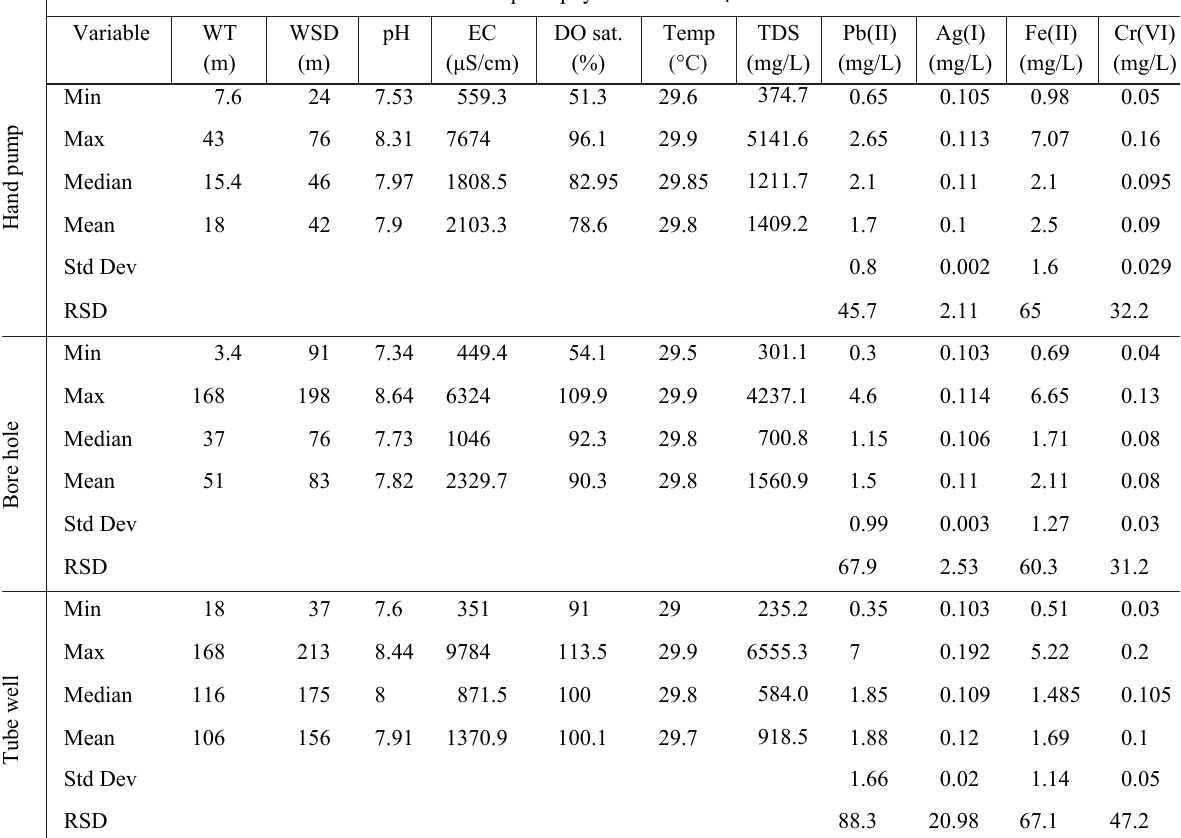
Table 1. Water table (WT), water source depth (WSD), physico-chemical parameters (pH, electrical conductivity (EC)), dissolved oxygen (DO) saturation, total dissolved solids (TDS) and heavy metals in different sources of the groundwater. Standard deviation (Std Dev) and relative standard deviation (RSD) are also